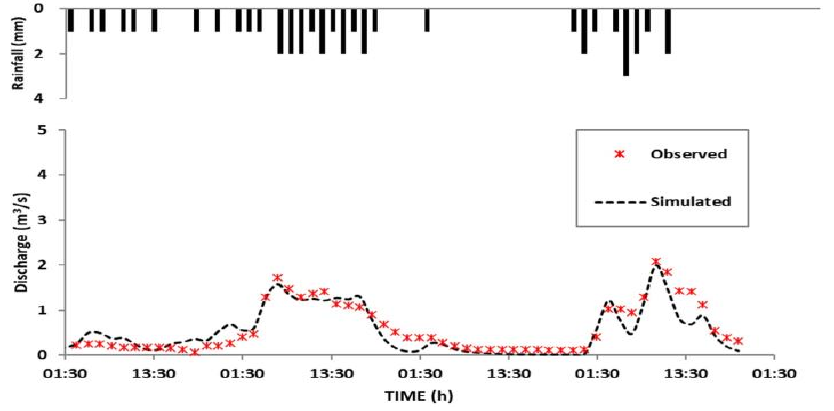
Figure 12. Comparison of Observed Discharge and Simulated Discharge (2010.6.12).